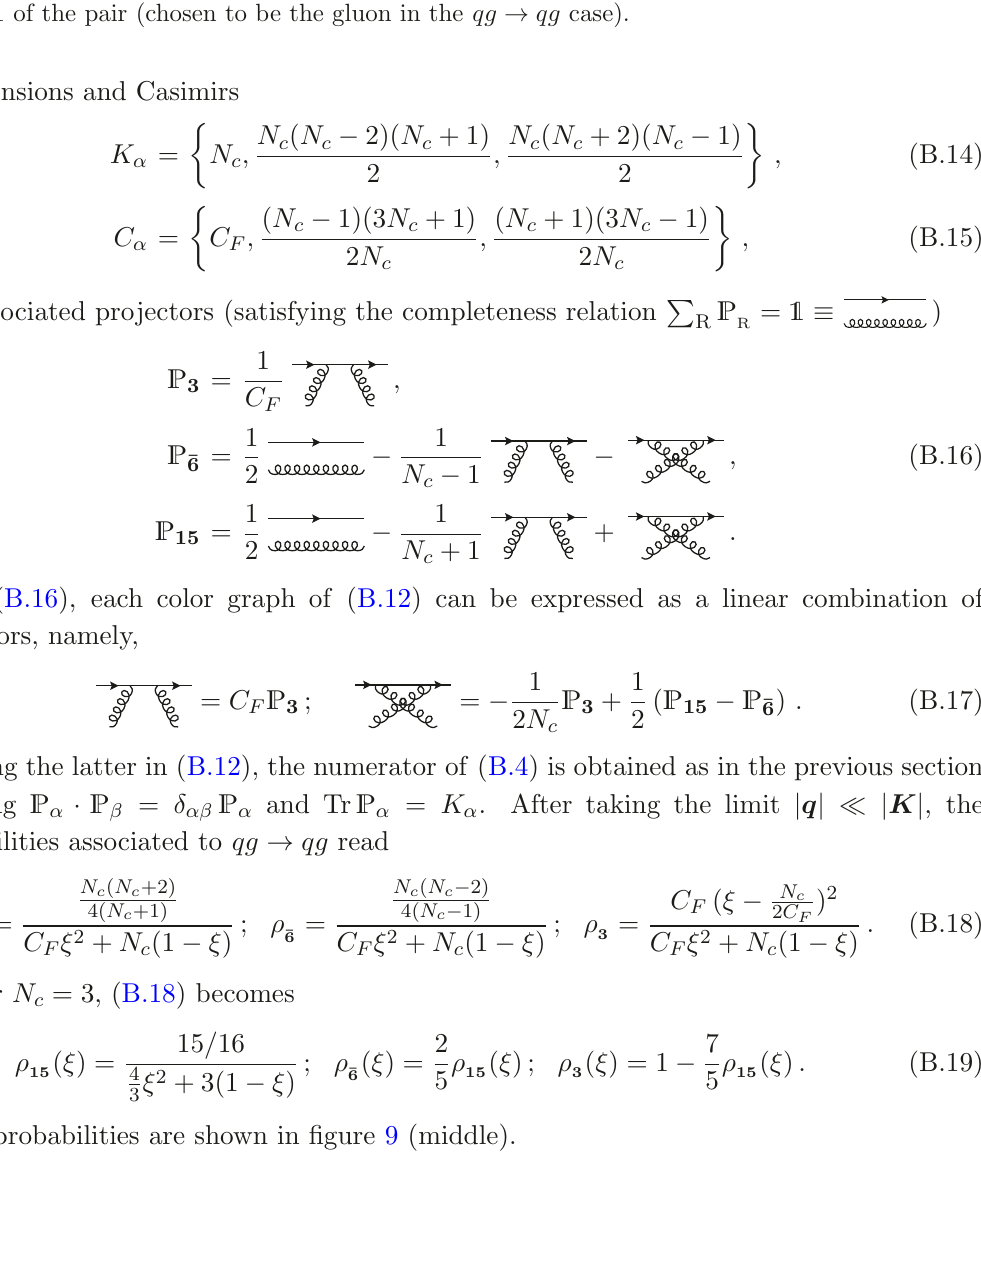
Figure 9 . Probabilities (cid:26) ( (cid:24) ) for the parton pair produced in gg R and gg q (cid:22) q (right) to be in color state R, as a function of the relative energy fraction (cid:24) carried by ! parton 1 of the pair (chosen to be the gluon in the qg